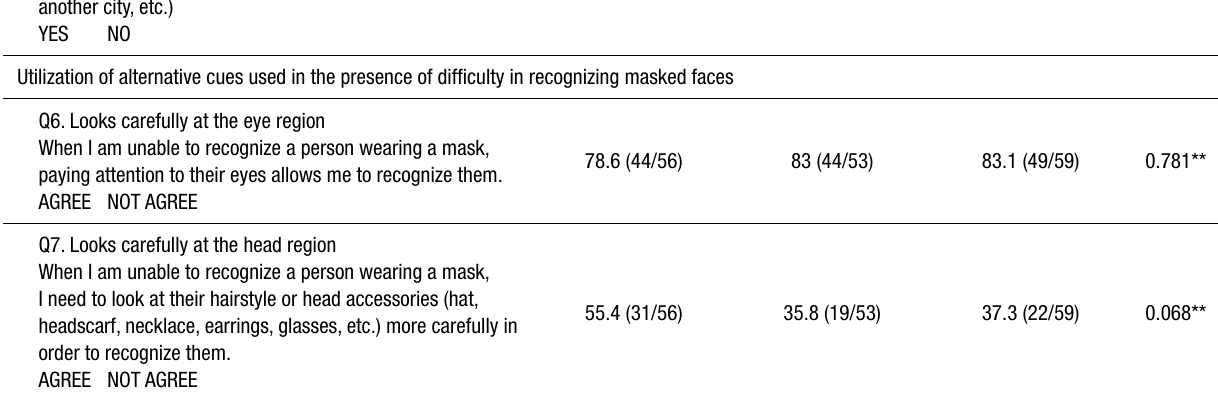
Patients with Older Parkinson’s disease % (yes, agree/total)